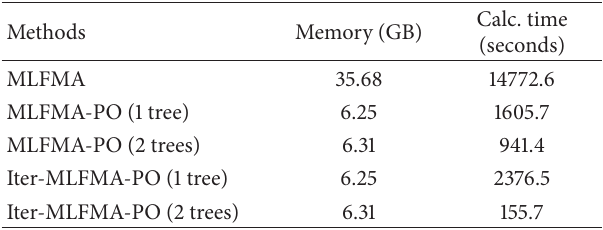
Table 2: Calculation time and memory requirement of different methods for the monopole mounted on a